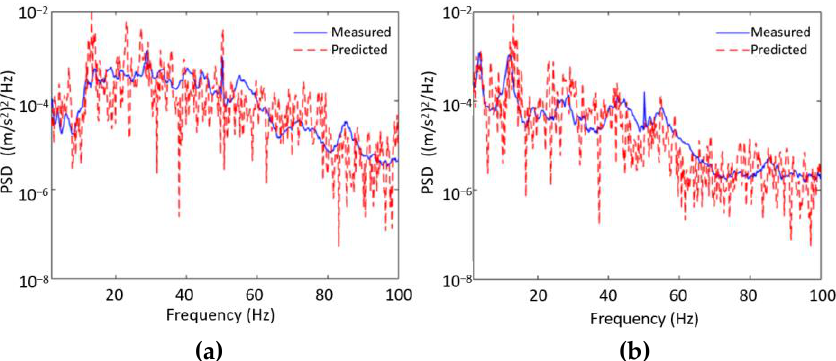
Figure 10. Power spectral density of seat acceleration in X- direction. ( a ) 350 km/h; ( b ) 250 km/h.